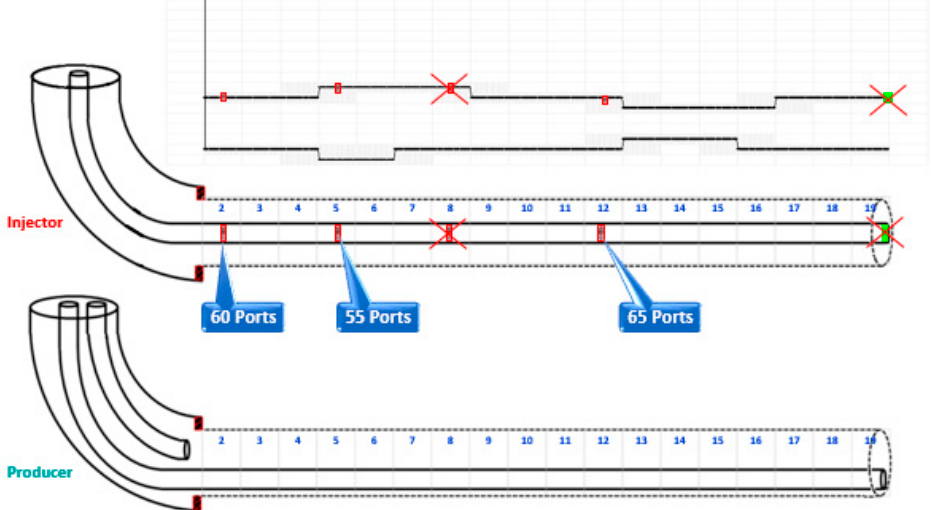
Figure 7. Optimum OCD cases.